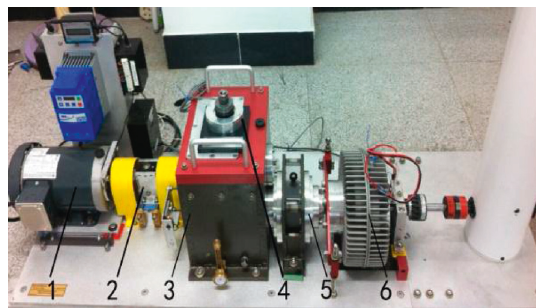
Figure 15: The multistage gear transmission system test rig.1: motor; 2: torque sensor and encoder; 3: two-stage fixed-axis gearbox; 4: radial bearing load; 5: one-stage planetary gearbox; 6: brake [18] (reproduced from Wang [18] (under the creative commons attribution license/ public domain)).